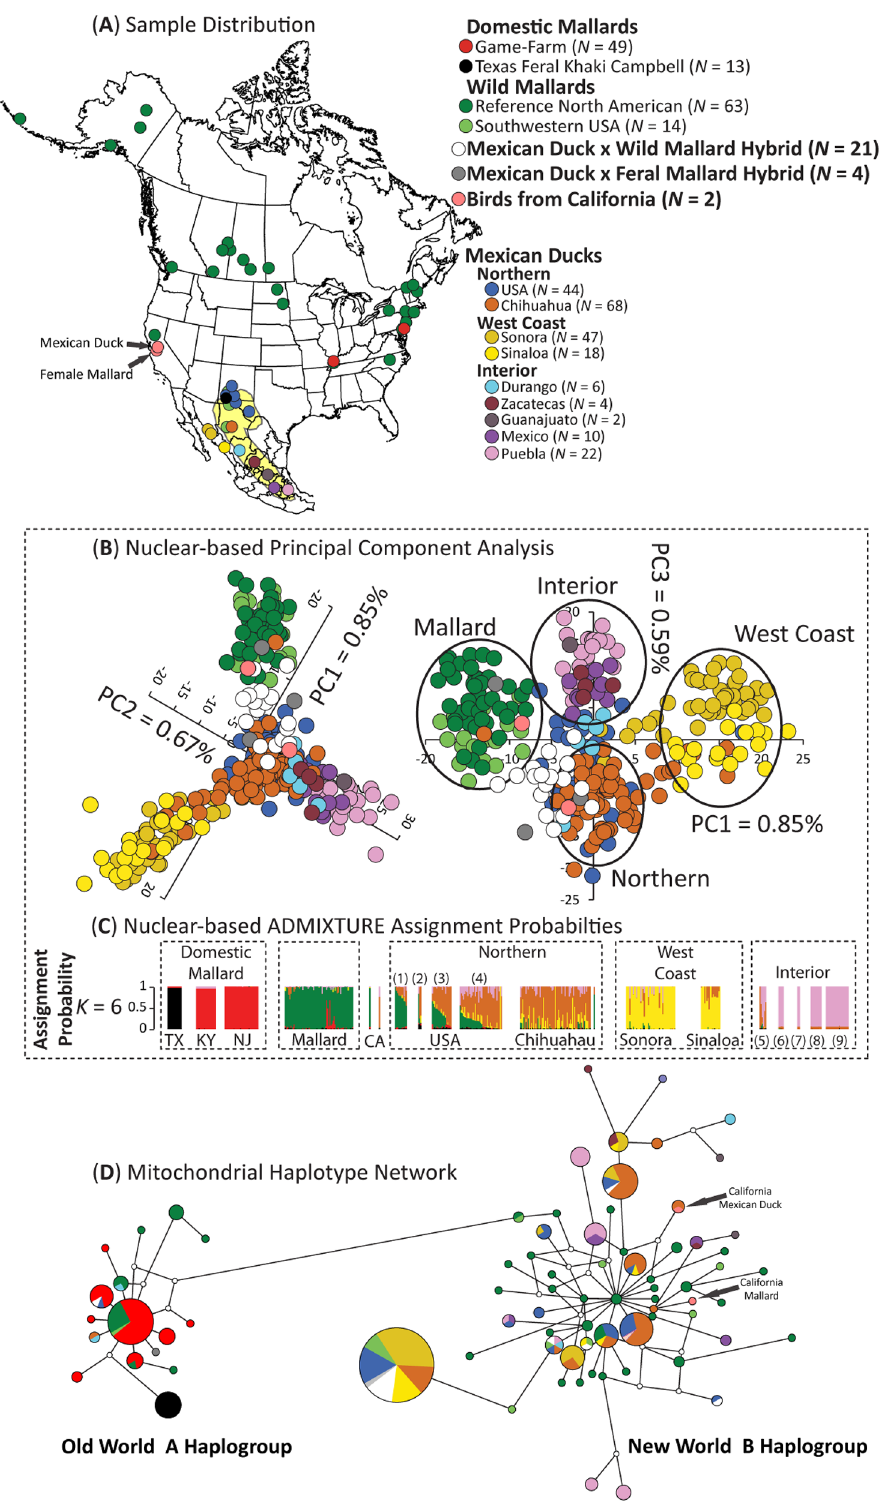
Figure 1. ( A ) Sample size and distributions of samples. ( B ) PCA and ( C ) ADMIXTURE assignments of sampled Mexican ducks, mallards, and putative hybrids, based on 12,696 bi-allelic ddRAD-seq nuclear SNPs. Numbered parentheses refer to different sample sites within the genetic cluster. Note that these analyses were based on 370 samples that excluded domestic mallards (Supplementary Materials Fig. S2) and all but one representative of each identified sibling group (Supplementary Materials Fig. S3). Finally, ( D ) a haplotype network based on 628 sequenced base-pairs of the mitochondrial control region. Note that we identify mallards by origin (wild vs. domestic) and Mexican ducks by geographical location in PCA and mitochondrial haplotype network, whereas assignment probabilities are colored by the six genetic clusters as estimated with